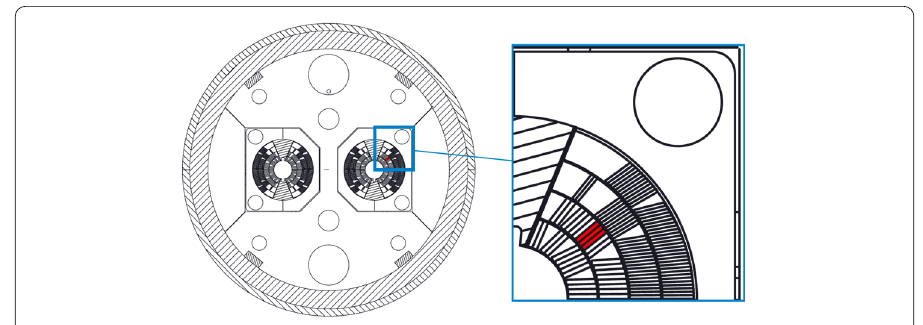
Figure 1 Cross-section of cos-theta magnet for FCC and HE-LHC. A stack of three Rutherford cables is highlighted in red